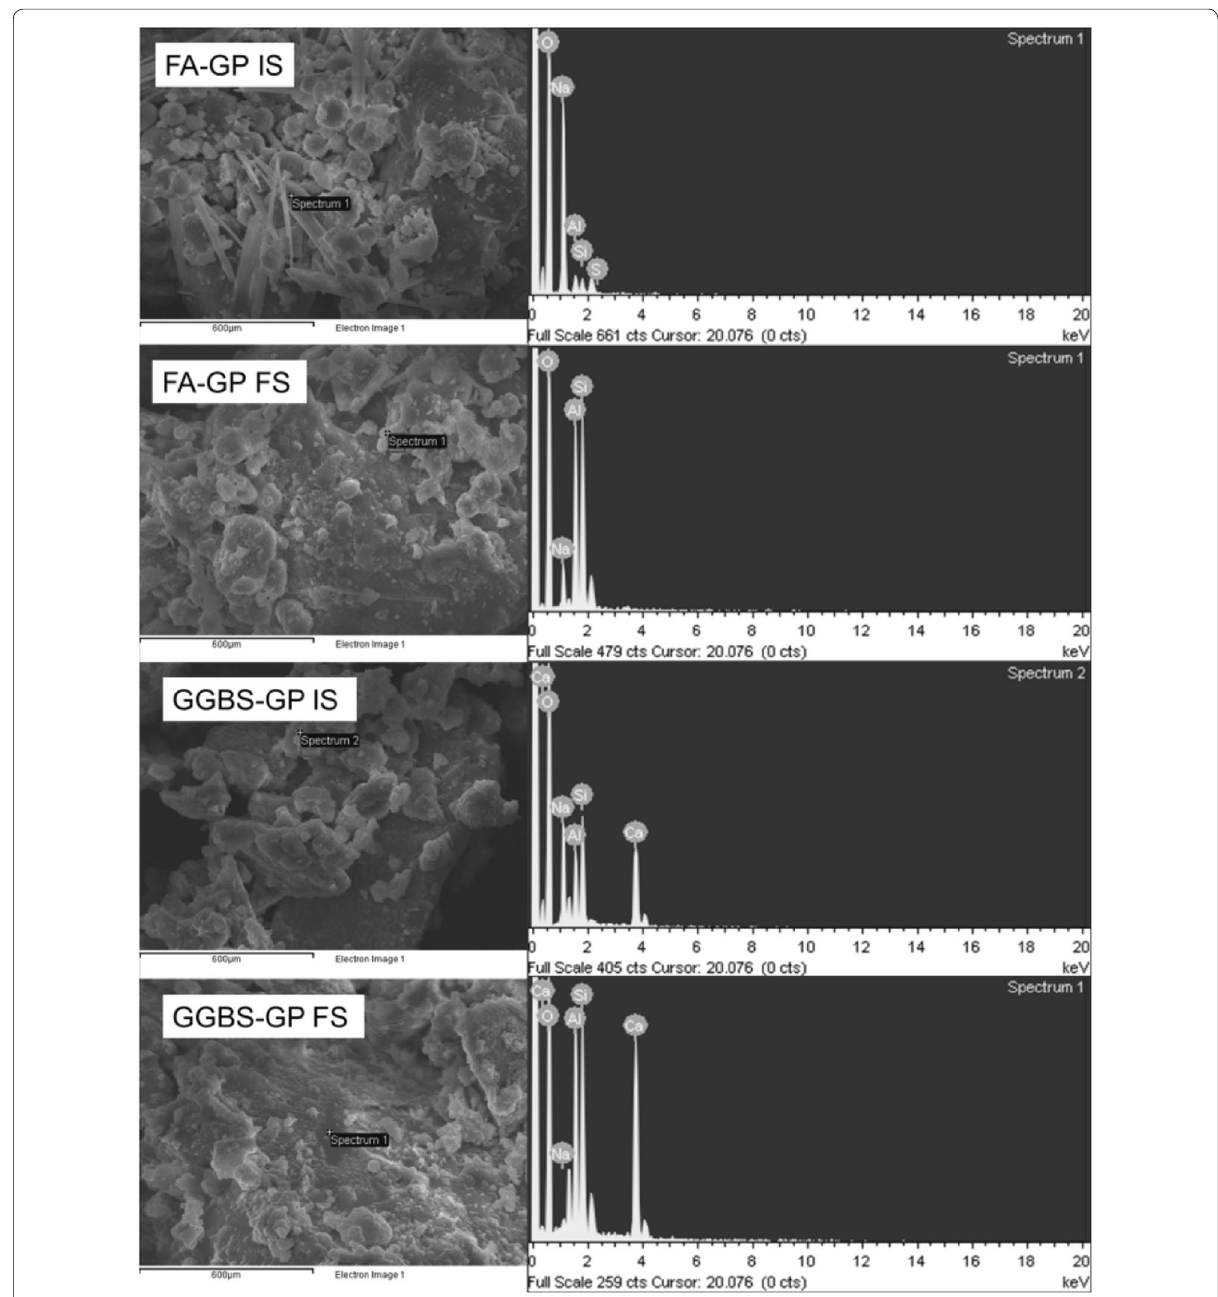
Fig. 4 SEM images with EDX map of geopolymers at setting